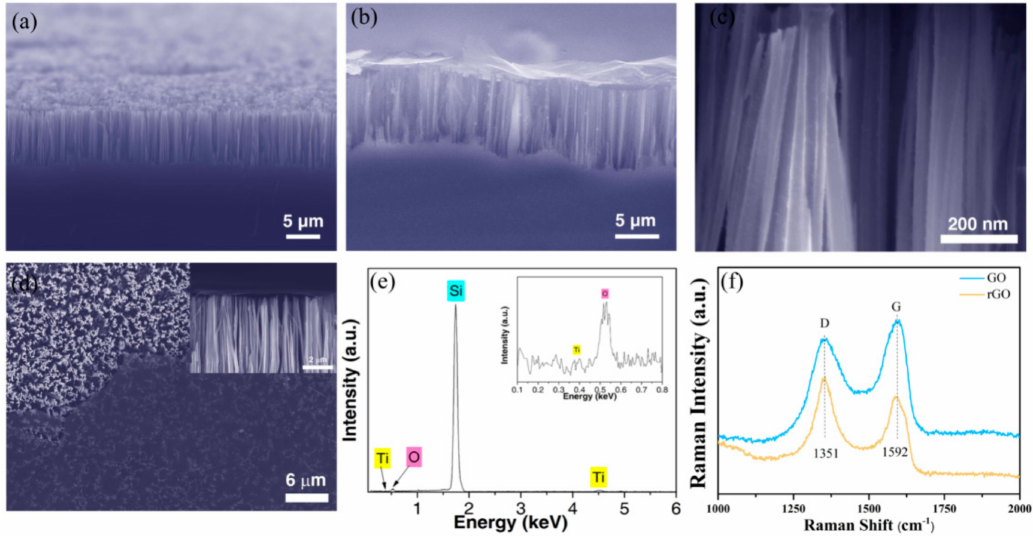
Figure 2. ( a ) Cross-section FESEM image of the SiNW array; ( b ) FESEM cross-section of the SiNW / ZnO / rGO heterojunction; ( c ) SEM image of SiNWs decorated with TiO 2 nanoparticles; ( d ) SEM image of the SiNW / TiO 2 / rGO Schottky heterojunction; the inset is a side screenshot; ( e ) XPS of the SiNW interface layer decorated with TiO 2 nanoparticles; ( f ) Raman spectra of GO and rGO